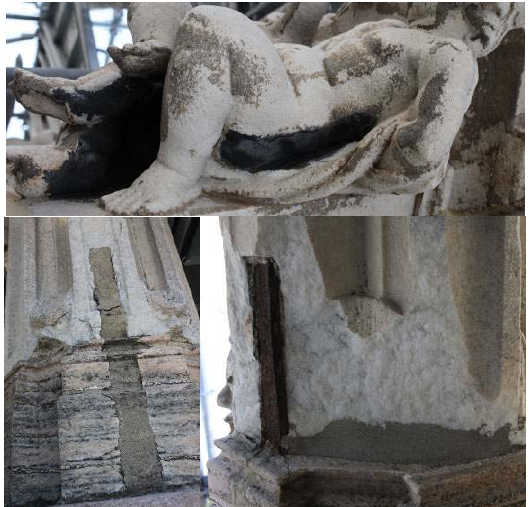
Figure 4: Degradation of marble blocks. In the image above the presence of black crust and artificial patinas. Candoglia marble has a significant pyrite content that may be sporadic or even have large aggregates of crystals. There are also rare grains of magnetite. The presence of metal minerals determines, unfortunately, a lack of durability, with the consequent need for damaged parts to be replaced continuous. Images below show an important detachment of material and deterioration of the old iron anchorage.